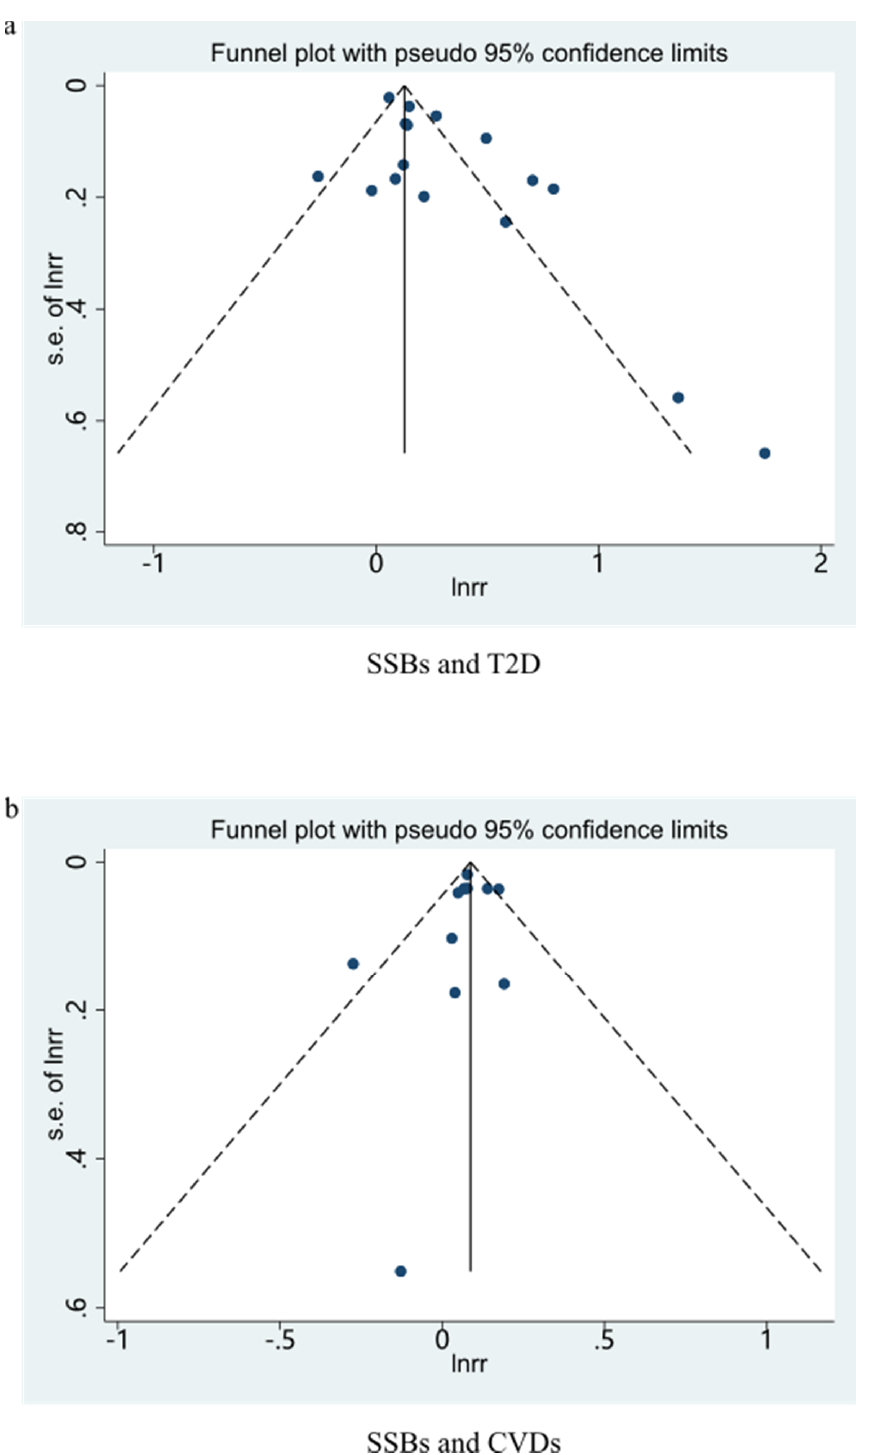
Figure 5. Funnel plot for examination of publication bias of studies (dose-response analysis). ( a ) Funnel plot for SSBs and T2D. ( b ) Funnel plot for SSBs and CVDs. SSBs, sugar-sweetened beverages; T2D, type 2 diabetes; CVDs, cardiovascular diseases.